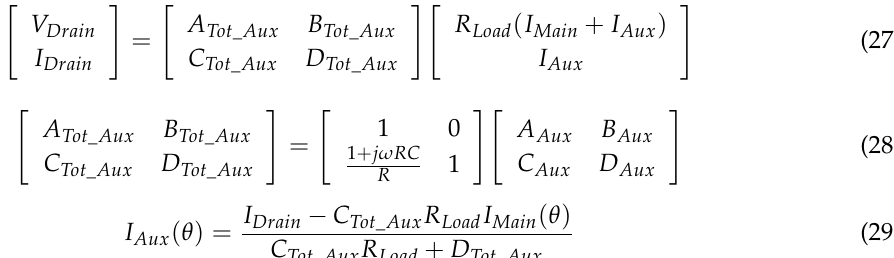
Figure 14. Schematic for the proposed Doherty output power combiner.